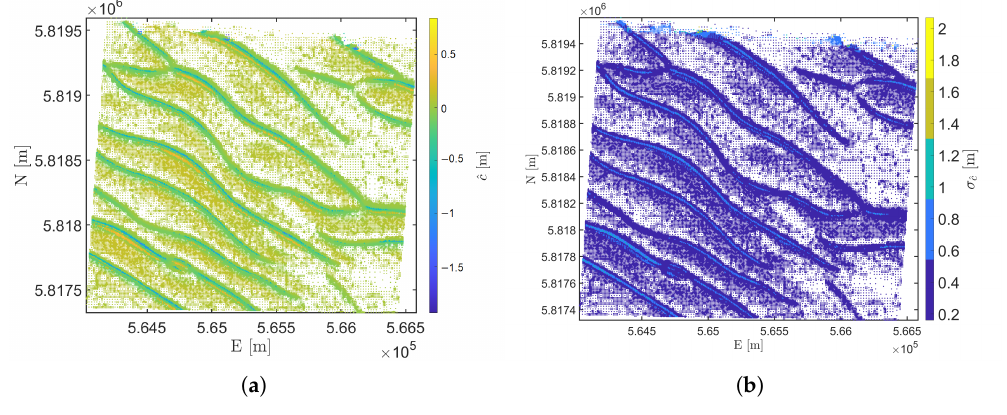
Figure 15. Area NF showing results of ( a ) ˆ c and ( b ) σ ˆ c